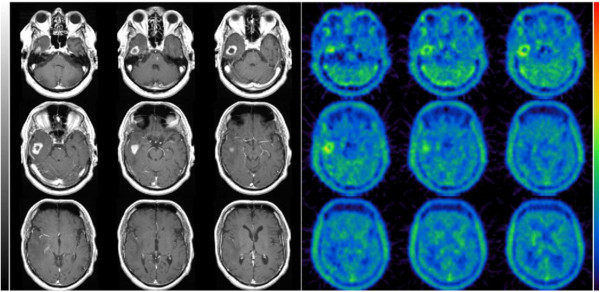
Example of recurrent brain metastasis: the study shows pathologic contrast enhancement on T1-weighted MRI and corresponding increased [18 F]-FET uptake. While radiation necrosis was suspected in MRI, PET showed a pathologic FET uptake as seen in recurrent metastasis.